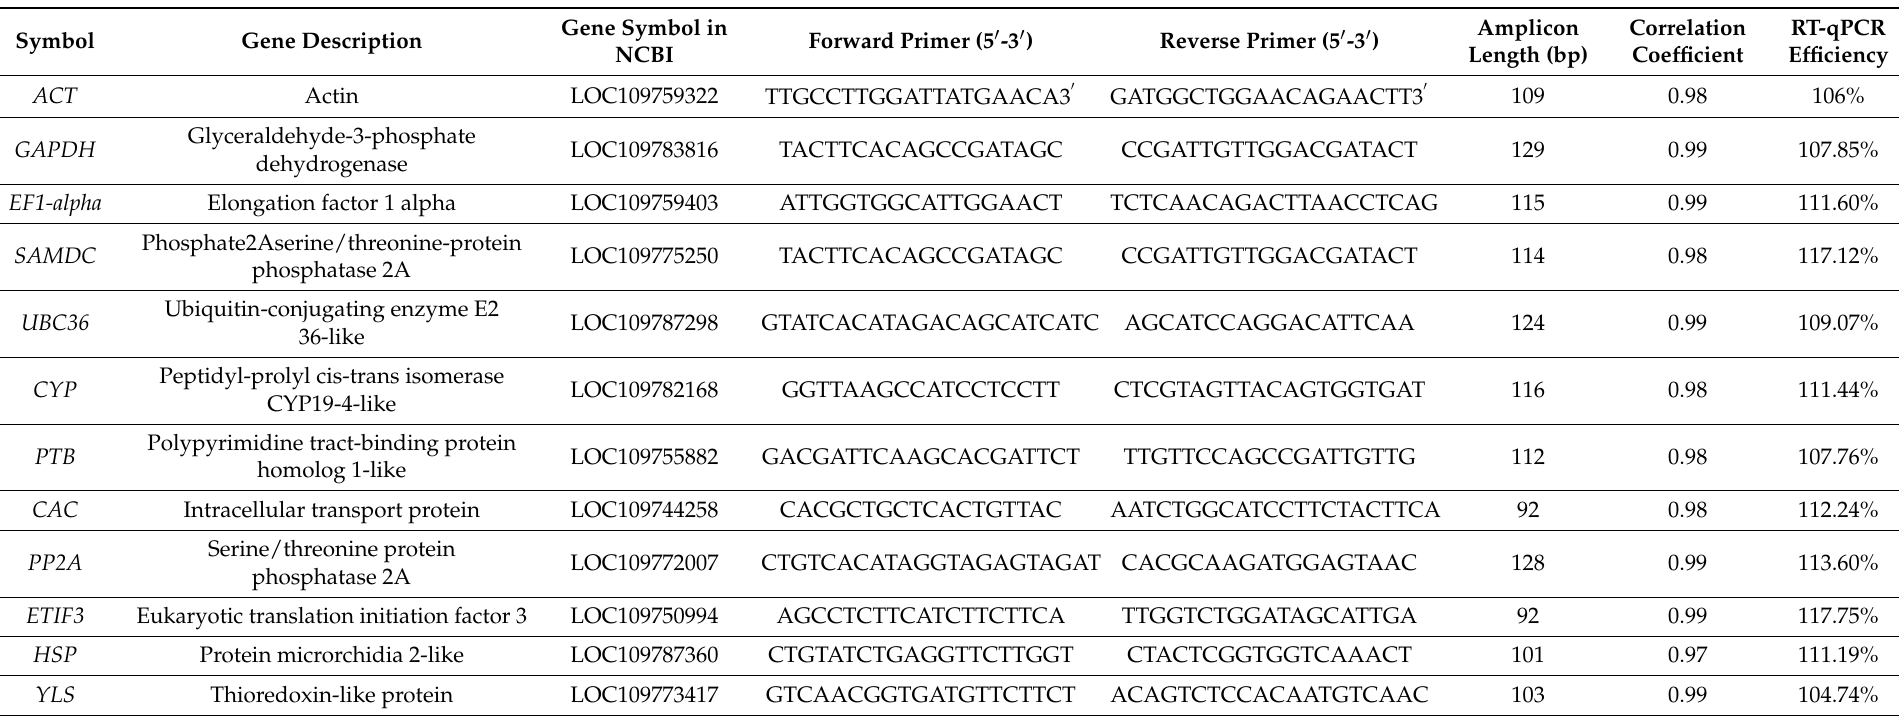
Table 1. Primer sequence (forward and reverse 5 (cid:48) -3 (cid:48) ), amplified characteristics, and 12 reference gene details for